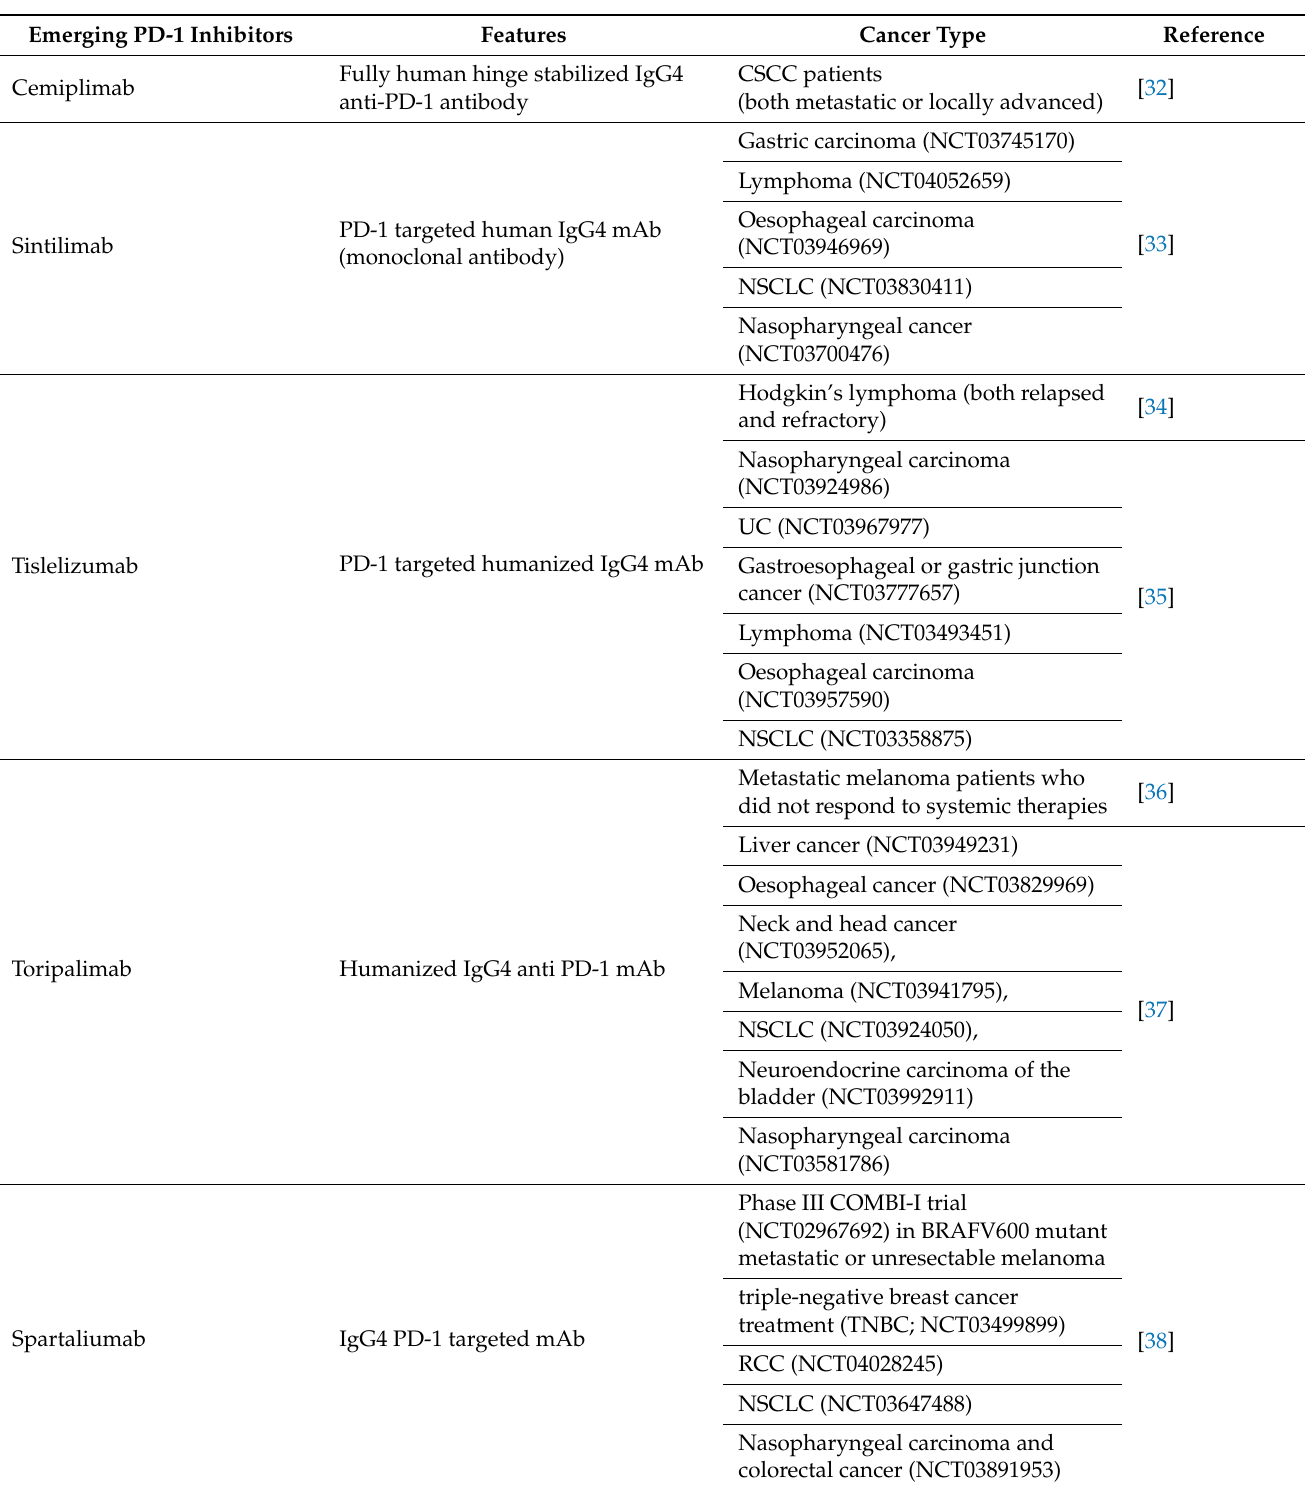
Table 2. FDA-approved PD-1 inhibitors which have displayed significant PD-1 inhibition in preclini- cal